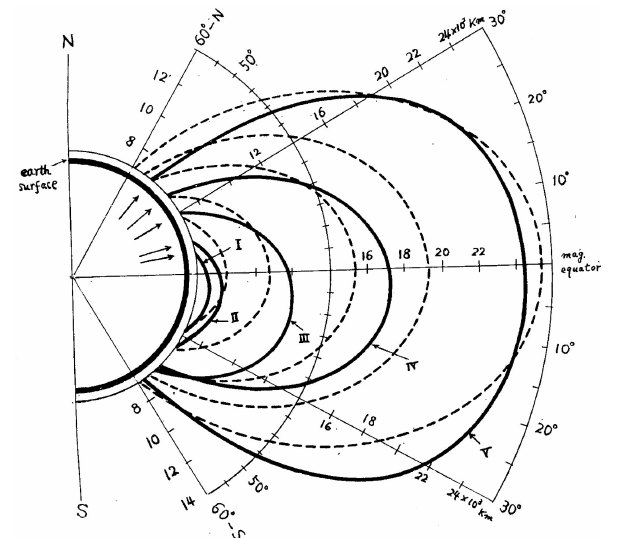
Figure 9. Comparison between the observed and the calculated variations of the electron density at the peak of F2 layer with lati- tudes (Yonezawa, 1956).